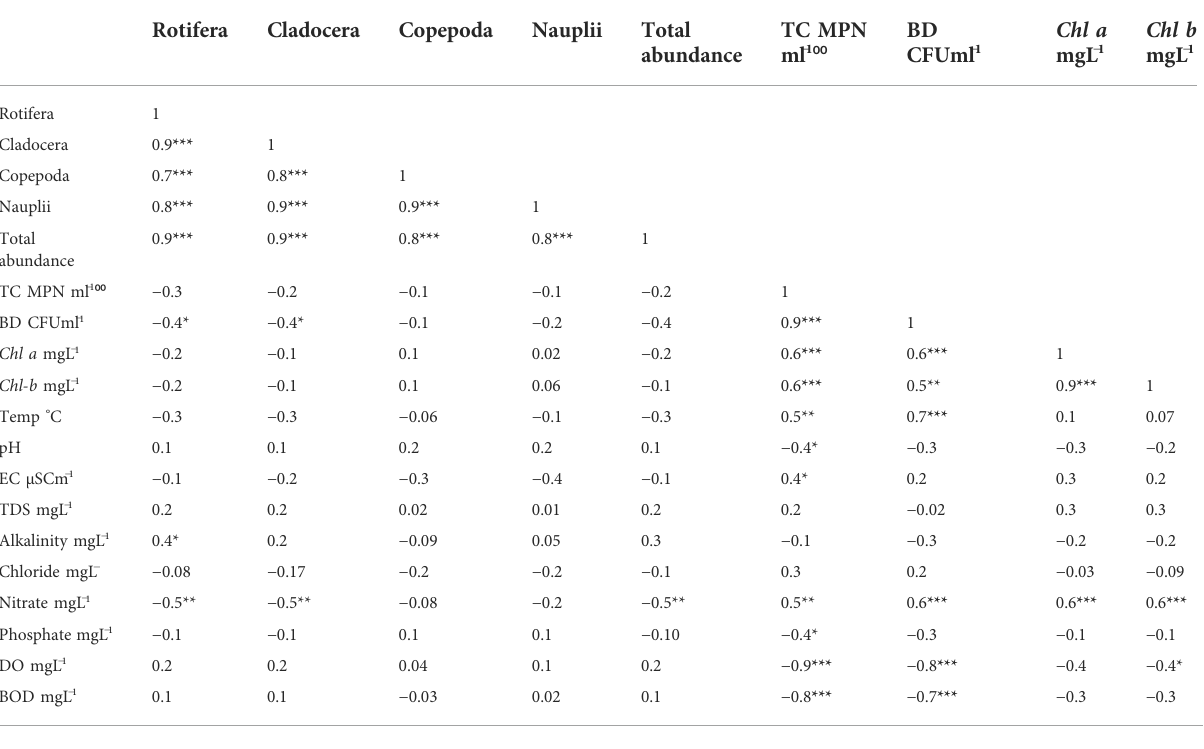
TABLE 4 Pairwise multiple correlations using Pearson correlations (R) among zooplankton major groups (Rotifera, Copepoda, and Cladocera), with biotic (bacterial density CFU, total coliform, and Chl a ) and abiotic parameters (pH, EC, temperature, BOD, DO, TDS, chloride, alkalinity, nitrate, and phosphate). * p < 0.1, ** p < 0.05, and *** p < 0.01.